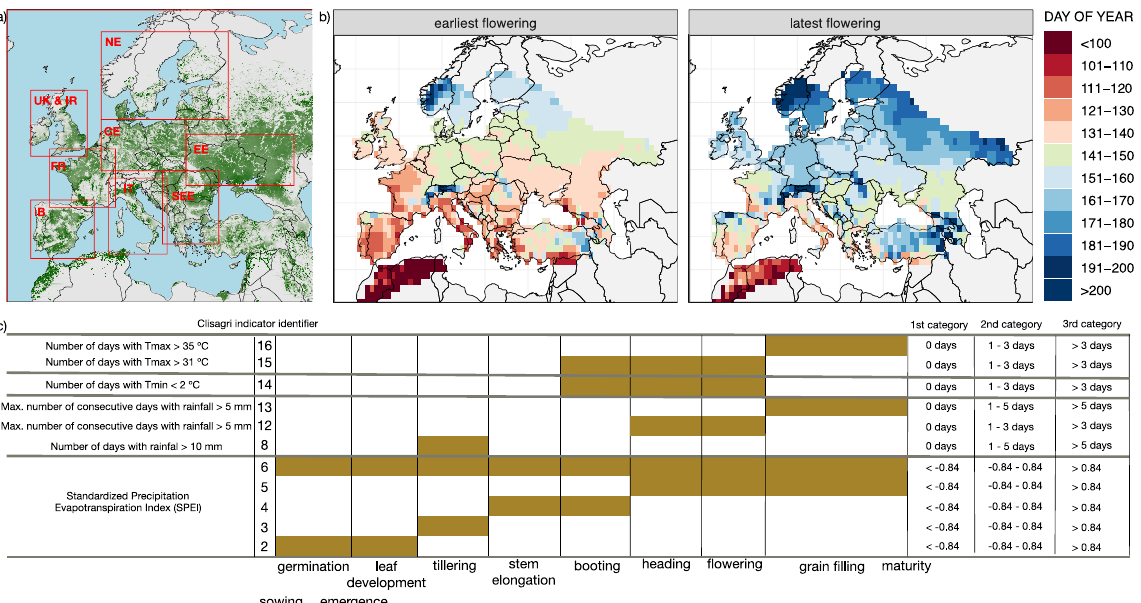
Fig. 4 Agro-climate indicators for winter wheat-producing regions. a Spatial distribution of European arable cropland (green areas) and the regions used in the seasonal prediction reliability assessment (delimited by red lines): IB-Iberia, IT-Italy, FR-France, SEE-south-eastern Europe, CE-central Europe, NE-northern Europe, UK & IR-UK and Ireland, and EE-eastern Europe. b Earliest (left panel) and latest (right panel) simulated day of winter wheat fl owering in Europe based on observed meteorological data. c Agro-climate indicators used for the assessment of seasonal prediction skill and reliability. Each indicator is calculated for speci fi c period during the wheat growing season (the time spans are indicated by brown boxes; adapted from ref. 6 ). There are three groups of indicators based on: hydrological balance (SPEI calculated for the shown periods), excessive wetness, cold stress and heat stress. Thresholds for multi-categorical skill assessment are shown on the right side of the